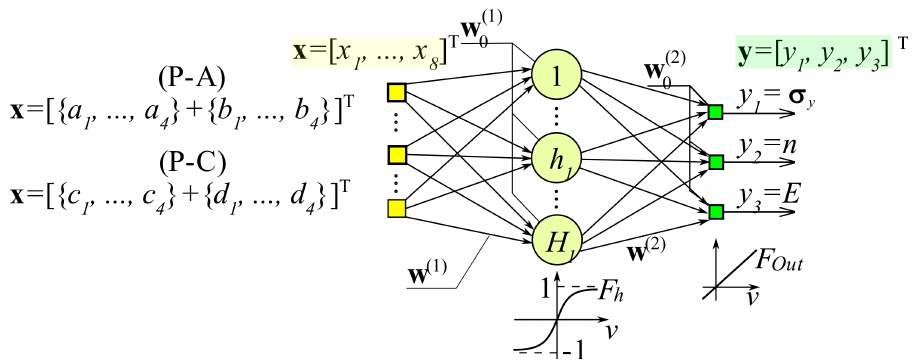
Figure 8. The structure of the applied MLP